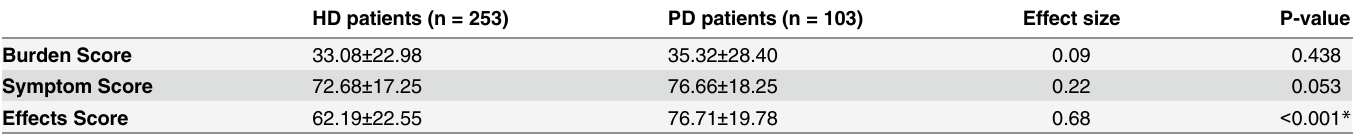
Table 7. Comparison of disease specific domains of KDQOL-36 between HD patients and PD